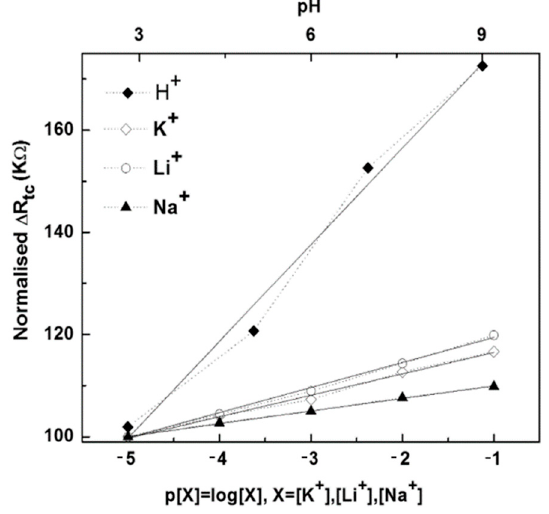
Figure 10. Calibration curve variation of normalized ∆ R ct as a function of the pH versus ( a ) K + , ( b ) Li + and ( c ) Na + concentrations from 10 − 5 M to 10 − 1 M at the Si/SiO 2 /HfO 2 structure (thickness 39.9 nm).